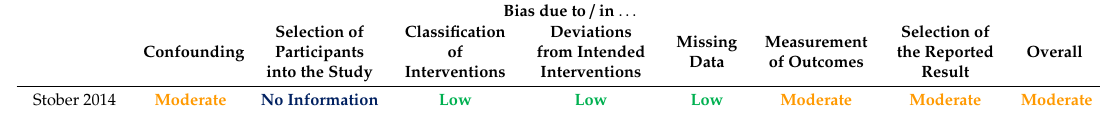
Table 2. Risk of bias of the included non-randomized studies (ROBINS-I tool). Bias due to / in ...